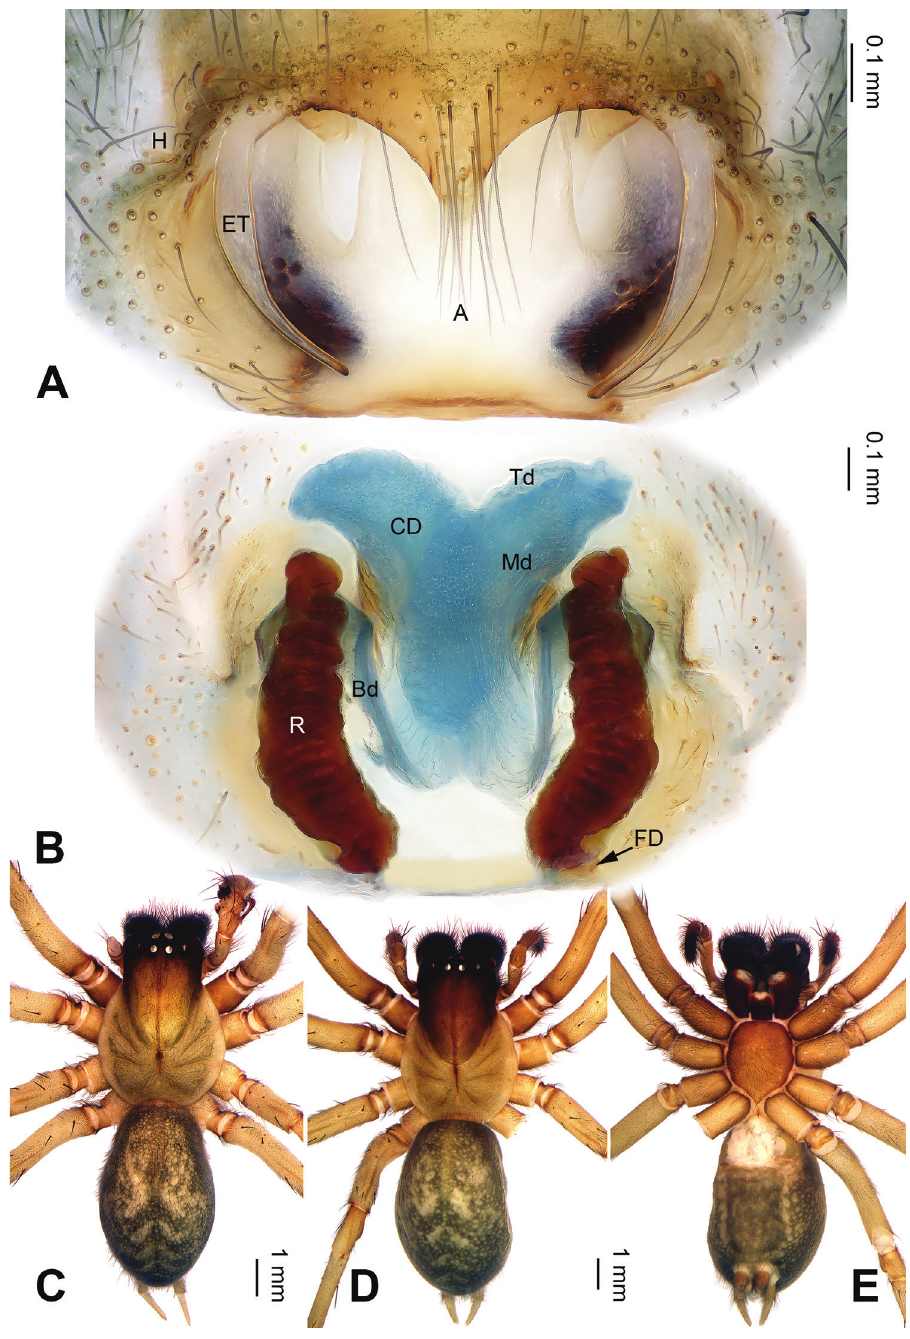
Figure 10. Pireneitega xiyankouensis sp. n., female paratype and male holotype. A Epigyne, ventral view B Vulva, dorsal view C Male habitus, dorsal view D Female habitus, dorsal view E Female habitus, ventral view. Scale bars: equal for D, E